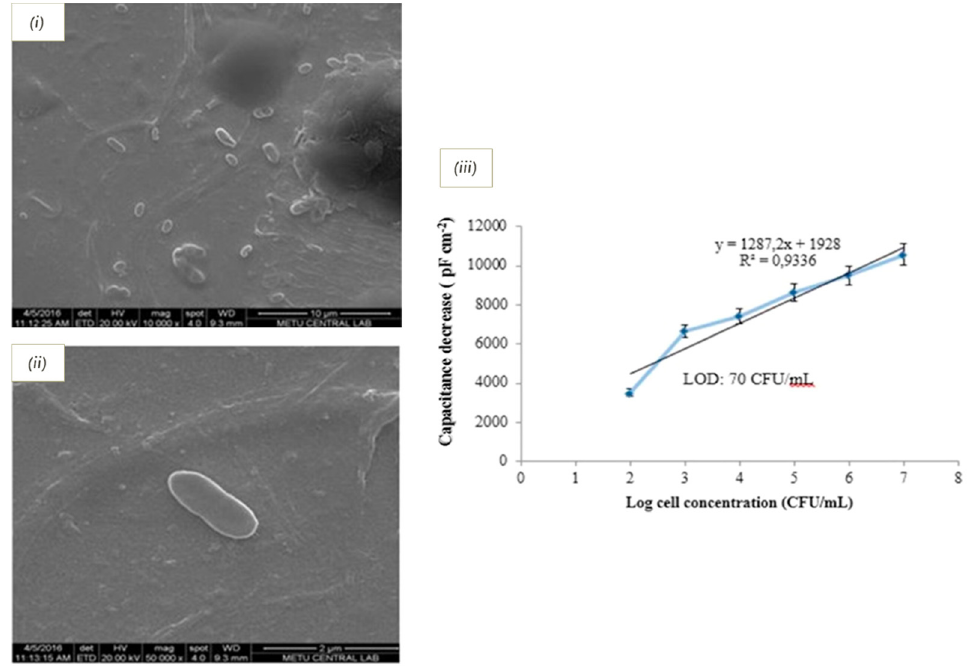
Figure 8. Electrochemical detection of Escherichia coli: ( i , ii ) SEM images of bacteria imprinted electrodes; and ( iii ) calibration curve obtained from the capacitive response of the electrode towards the analyte. Reprinted from [209]. Copyright (2017), with permission from Elsevier. Table 6. Imprinted polymer-electrochemical sensors for food safety.